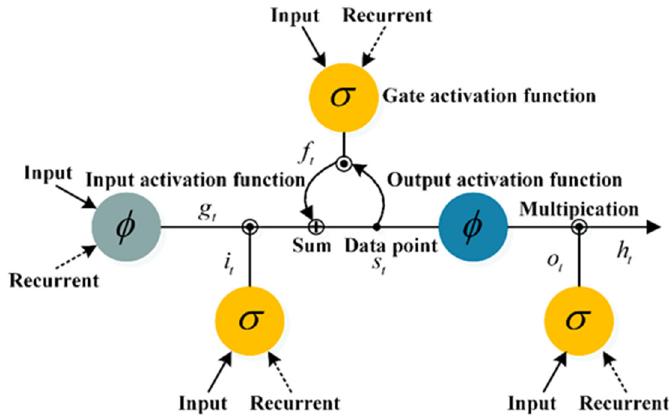
Figure 2. Long-short term memory (LSTM) model.